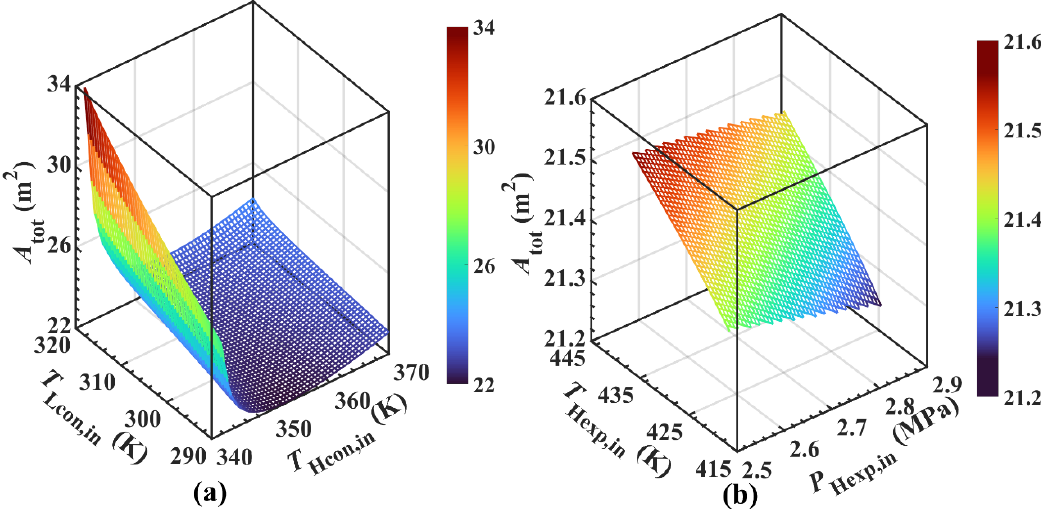
Figure 10. Influence characteristics of key variables on the system heat transfer surface. ( a ) Effect characteristics of inlet temperature in a condenser on the system heat transfer surface in the HT cycle and the LT cycle. ( b ) Effect characteristics of the parameters of the expander in the HT cycle on the system heat transfer surface.